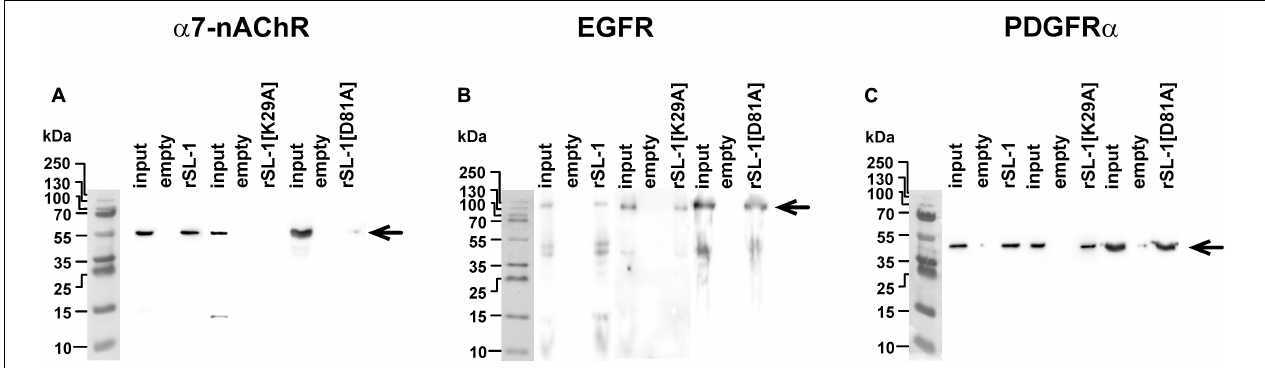
FIGURE 6 | Analysis of rSLURP-1 targets in A549 cells. NHS-Sepharose coupled with rSLURP-1 or rSLURP-1[K29A] and rSLURP-1[D81A] mutants was incubated with a membrane fraction of A549 cells and extracted proteins were analyzed by Western blotting using antibodies against α 7-nAChR (A) , EGFR (B) , and PDGFR α (C) . For detection of EGFR non-reducing SDS-PAGE was used. Lines: “Input”–the membrane fraction of A549 cells used for analysis; “empty”–proteins extracted from the membrane fraction by empty resin without rSLURP-1 or its mutant; “rSL-1”, “rSL-1[K29A]” or “rSL-1[D81A]”–proteins extracted from the membrane fraction by resin coupled with rSLURP-1 or its mutants. Bands corresponding to the α 7-nAChR, EGFR, and PDGFR α receptors are shown by